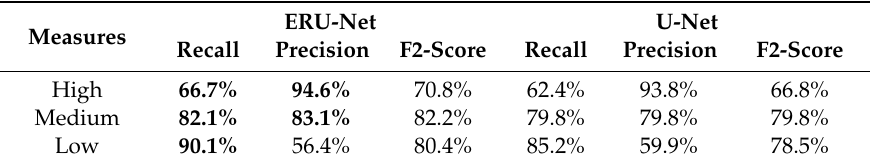
Table 4. The recognition results in di ff erent distributions (bold in the table means the best results on this evaluation index).